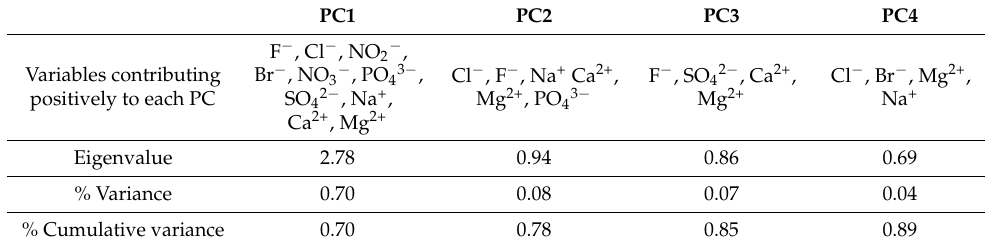
Table 4. Factor loadings for PM 10 in different principal components using the pooled data from all sites. PC1 PC2